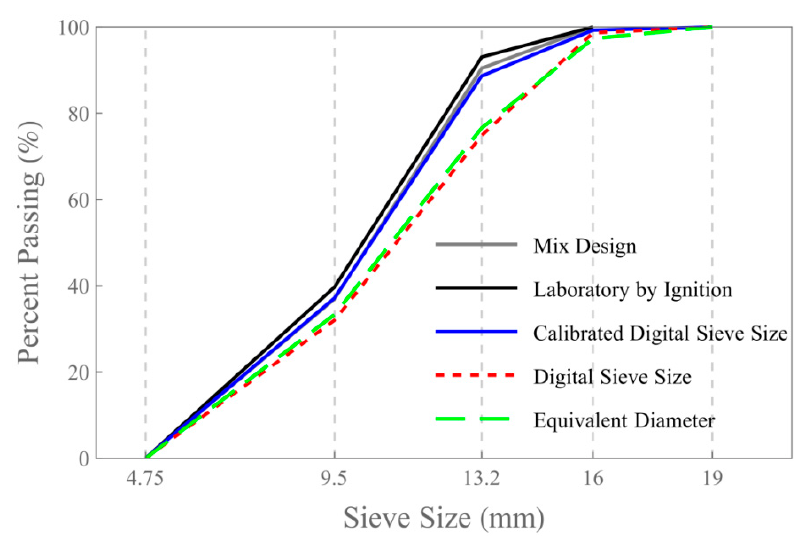
Figure 12. Gradation curves for Specimen 2.